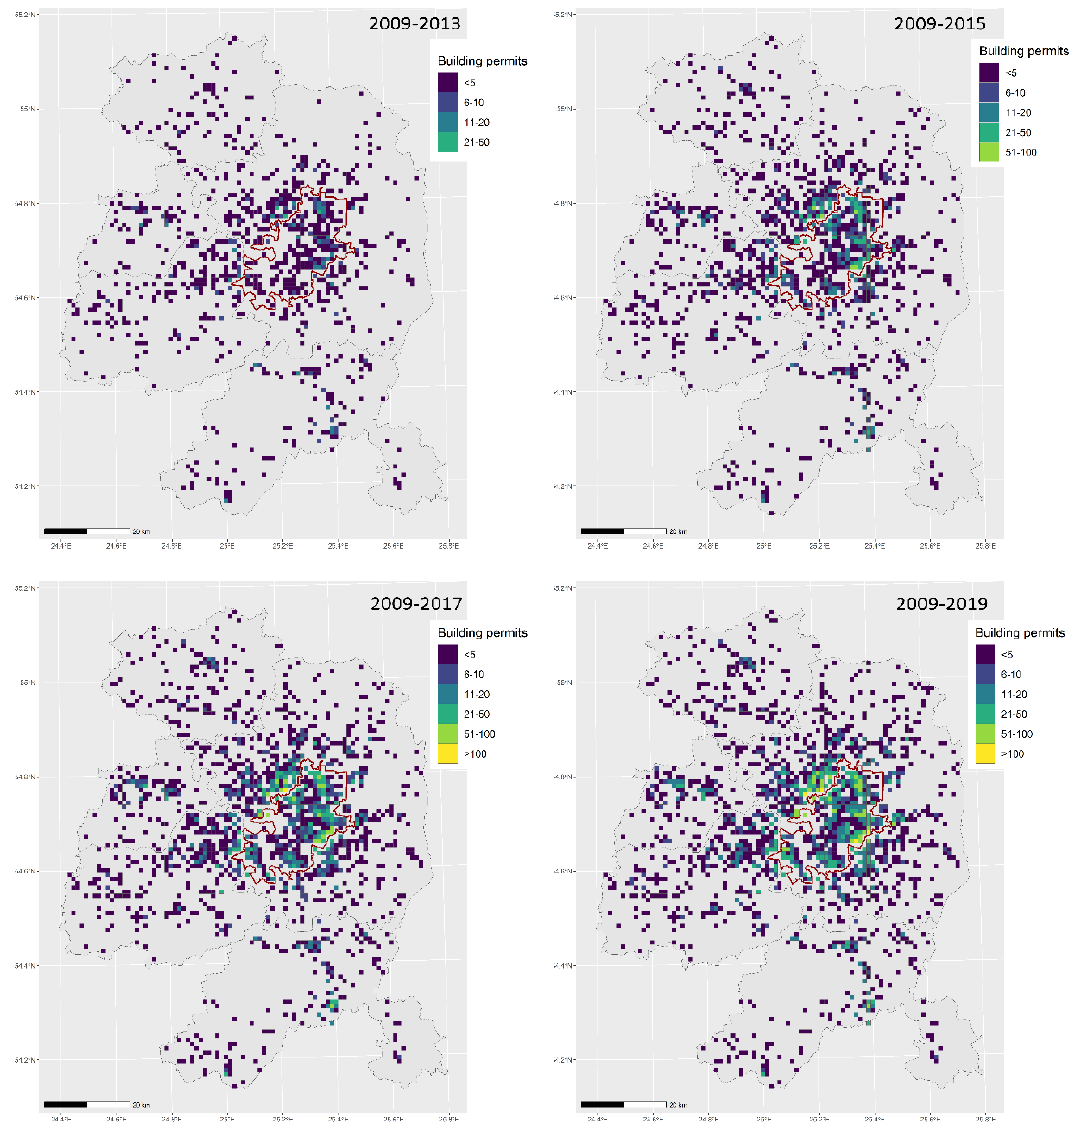
Fig. 3. The number of building permits issued in the Vilnius metropolitan area for detached and semi-detached family houses in 2009–2019, cumulative data; 1km X 1km grid (Source: own elaboration based on “Infostatyba”